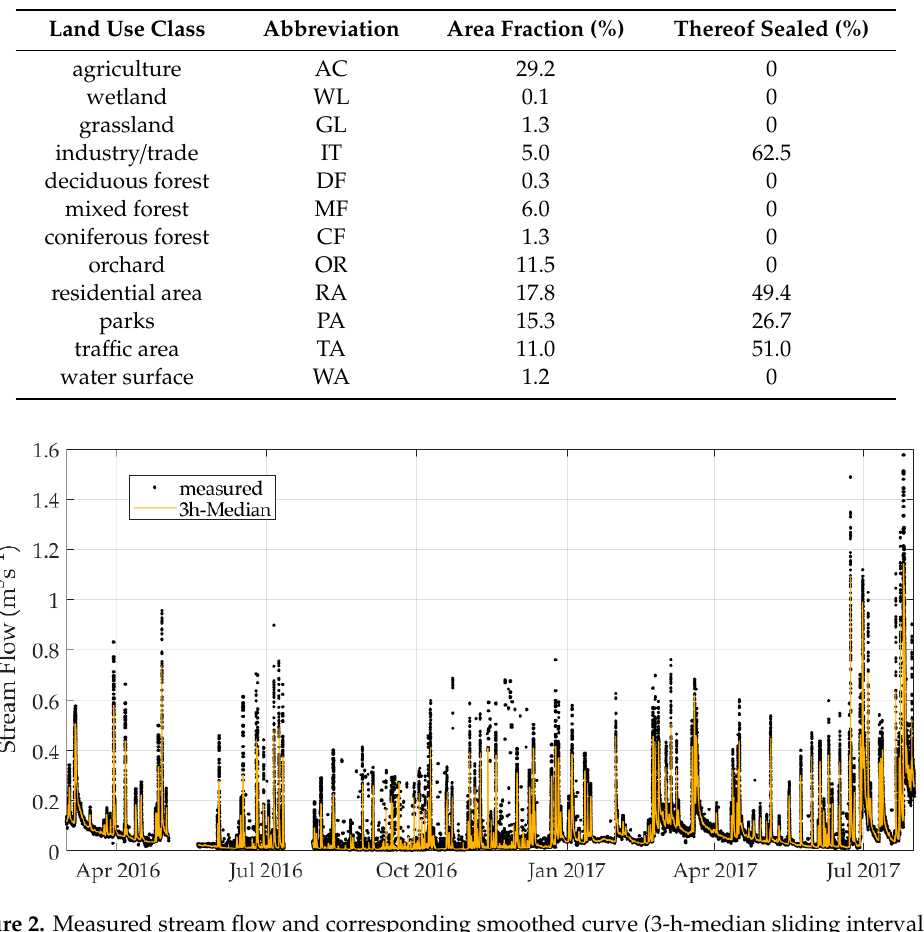
Figure 3. Measured stream flow and 3-day-minimum (sliding interval) to represent base flow at the monitoring station “Autobahn” (AB). 2.2. Software Description 2.2.1. SWMM The Storm Water Management Model SWMM is an open source software used for the simulation of the surface/subsurface runoff from primarily urban areas. It was developed by the United States Environmental Protection Agency (EPA) and combines a hydrological rainfall-runoff model with a hydrodynamic drainage model. The former traditionally consists of four compartments: (1) the atmosphere, (2) the land surface, (3) the sub-surface, and (4) the GW compartment. The rainfall-runoff model is semi-distributed and operates on a number of subcatchments consisting of permeable and impermeable sub-areas. Furthermore, SWMM’s version 5 introduces the low-impact development controls (LIDs), such as a bioretention cell or a green roof, used to calculate runoff, storage, and infiltration in a more detailed way [1,16]. Different calculation algorithms are available for the different compartments of the rainfall-runoff model; the ones used in this study are described below.